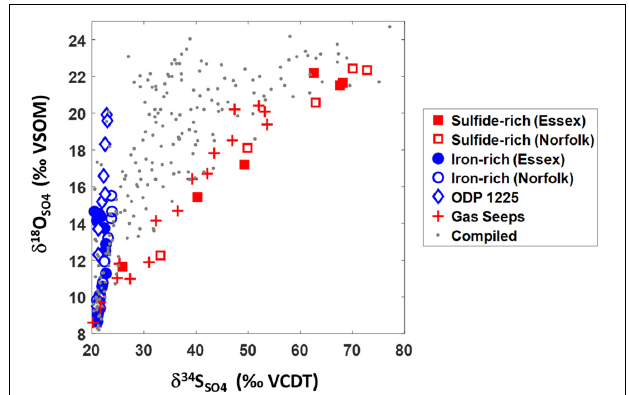
FIGURE 6 | δ 18 O SO4 vs. δ 34 S SO4 data from this study together with data from gas seeps (Rubin-Blum et al., 2014a), ODP site 1225 at the Peru Basin (Blake et al., 2006; Böttcher et al., 2006), and compiled data from 22 marine and marginal-marine sites (Böttcher et al., 1998, 1999; Aharon and Fu, 2000, 2003; Turchyn et al., 2006, 2016; Aller et al., 2010; Antler et al., 2013, 2014, 2015).